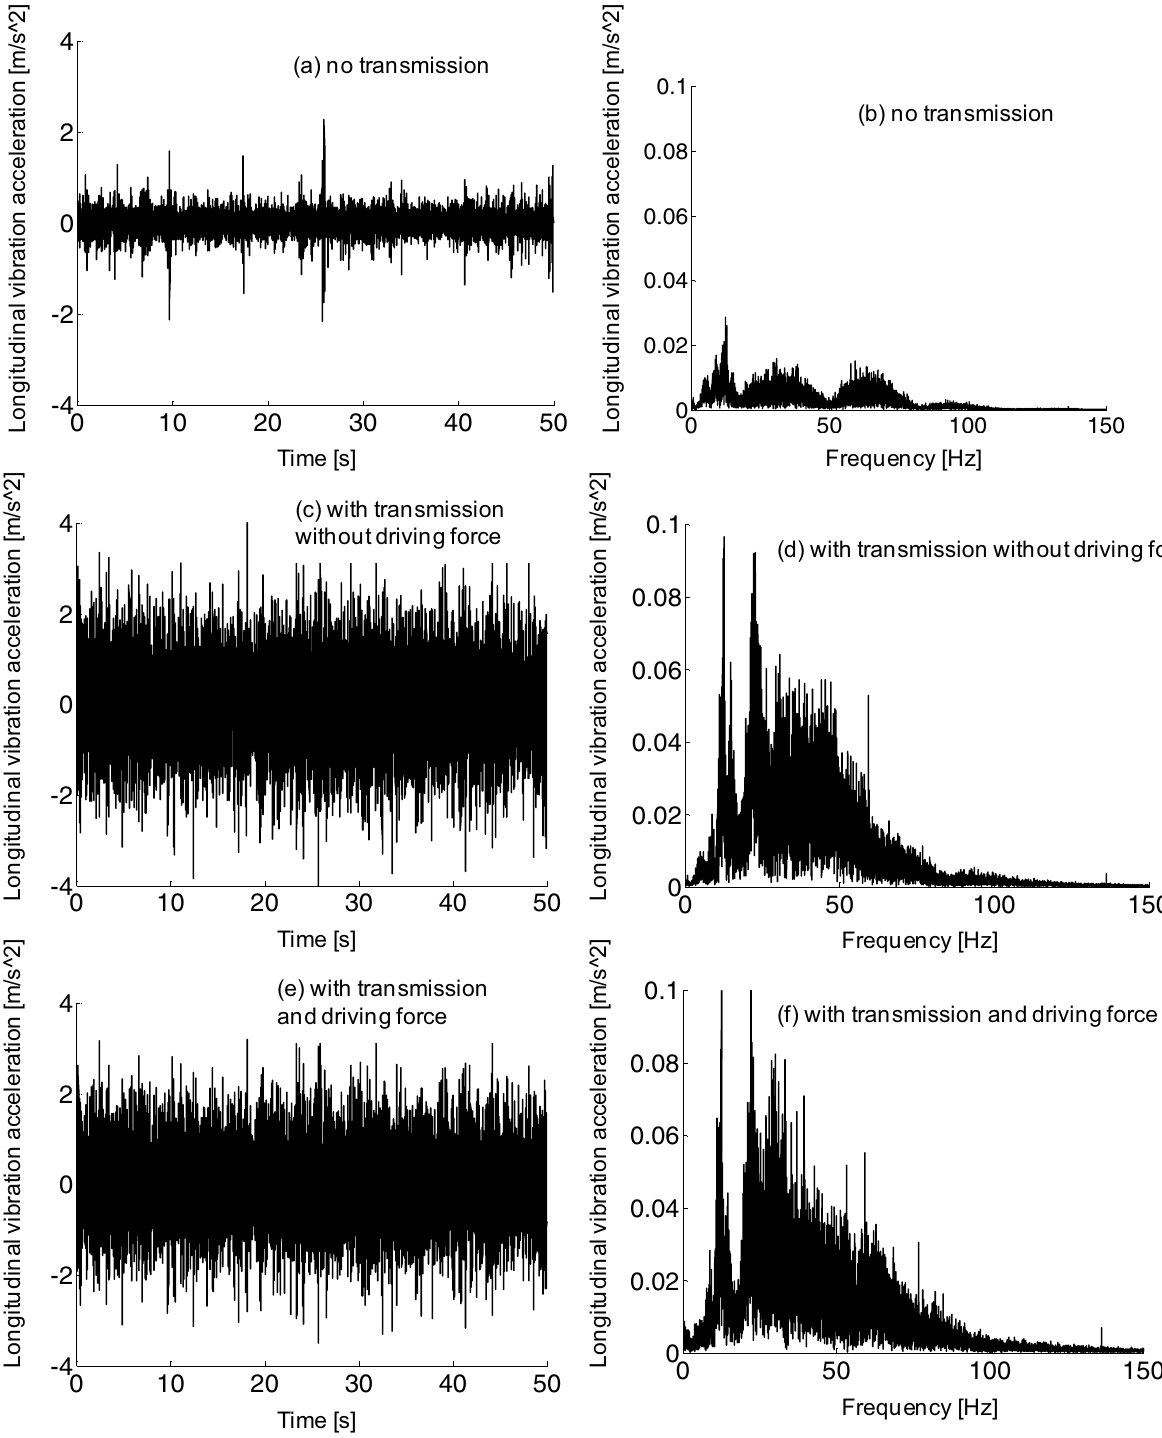
Figure 13. Frame longitudinal vibration acceleration, (a-b) no transmission, (c-d) with transmission without driving force, (e–f) with transmission and driving